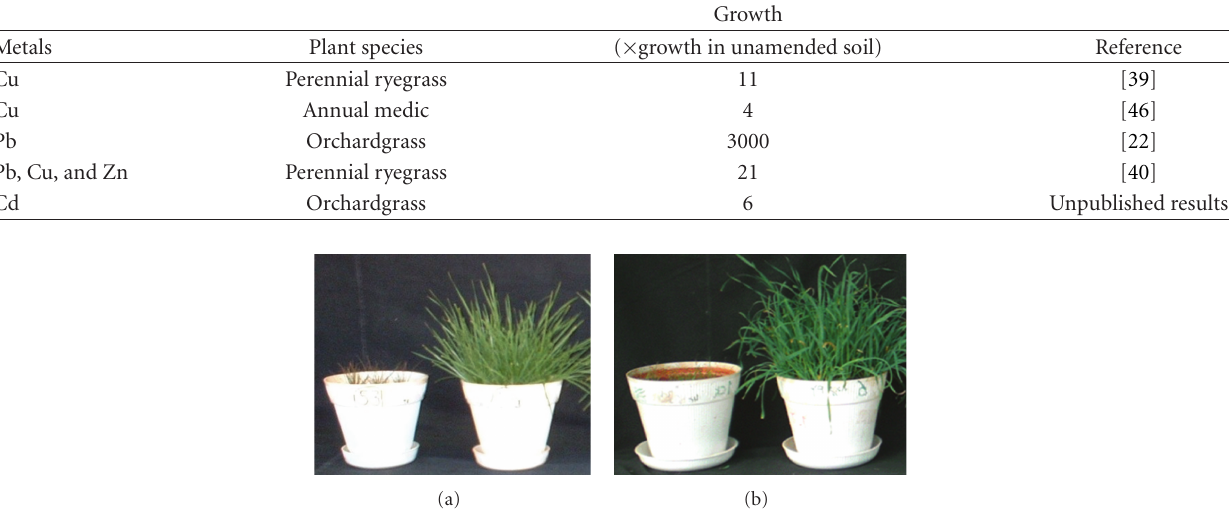
Figure 4: Growth of perennial ryegrass (a) and of orchardgrass (b) in mine soils without (left of picture) or with 0.2% (right of picture) of polyacrylate polymers.